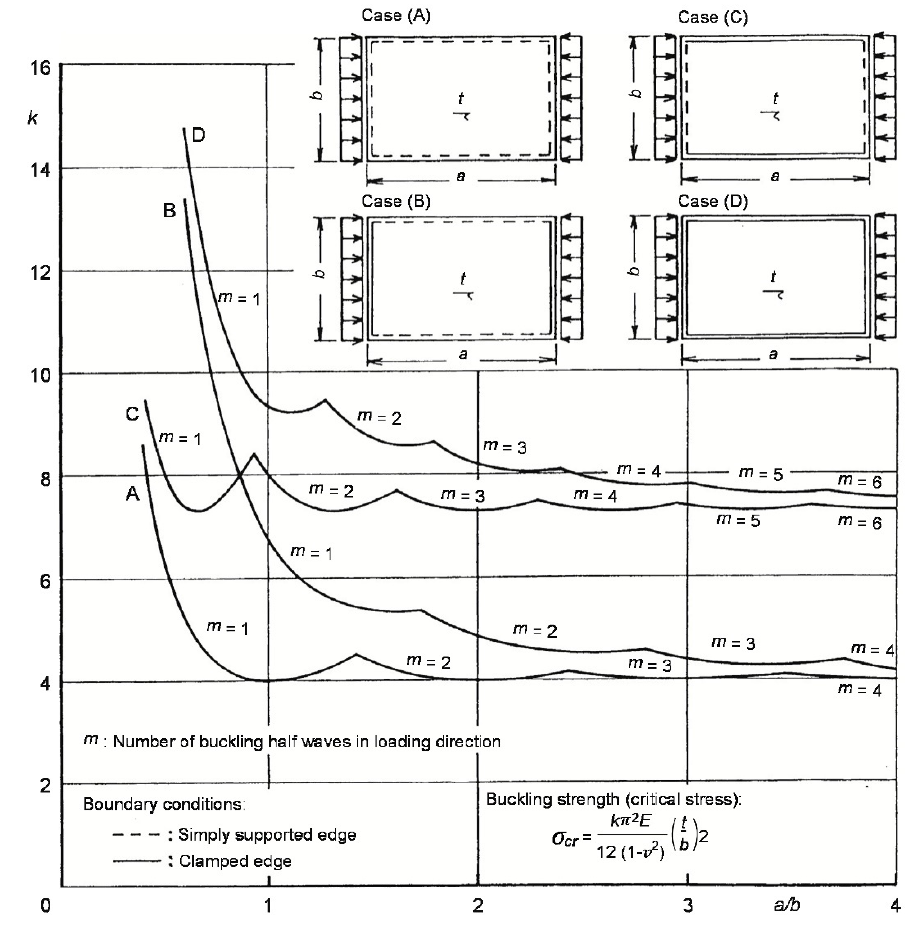
Figure 2. Buckling coefficient for rectangular plate versus the aspect ratio a/b [1].